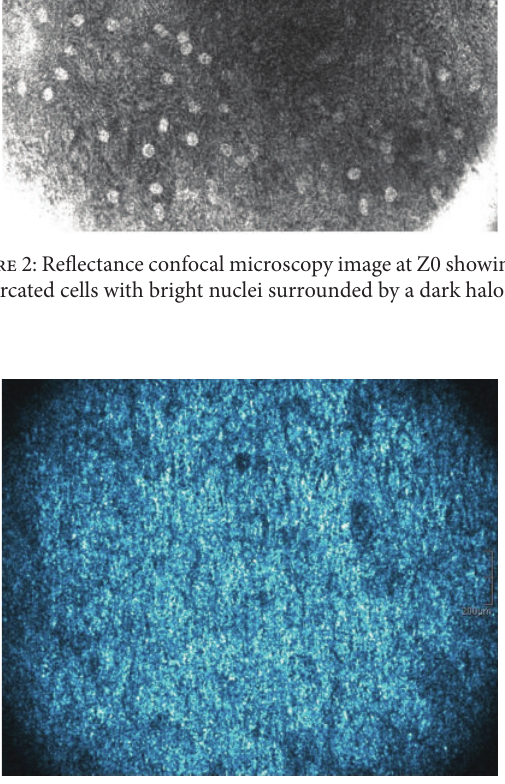
Figure 3: High-definition optical coherence tomography “en-face” image at supreficial epithelial